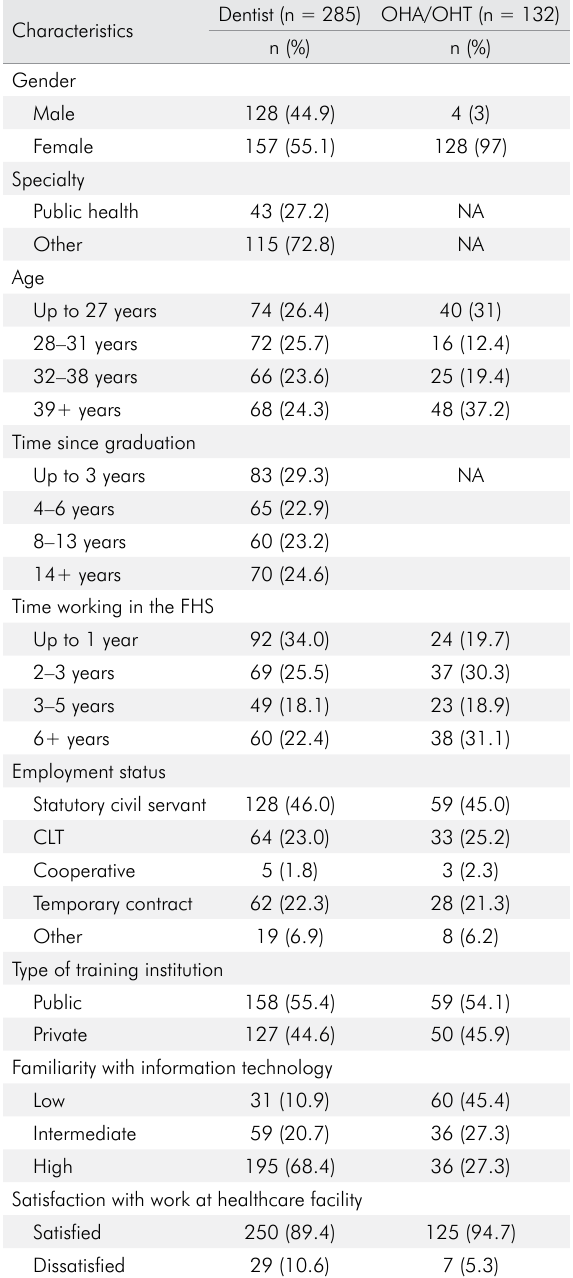
Table 1. Description of the study sample.